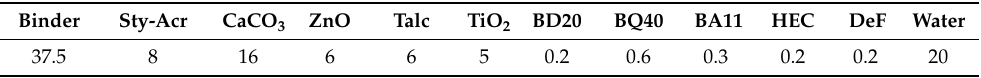
Table 1. Recipe for the preparation of the silicate and sol-silicate coatings. The values are weight percentages of the component in the coatings. Binder Sty-Acr CaCO 3 ZnO Talc TiO 2 BD20 BQ40 BA11 HEC DeF Water